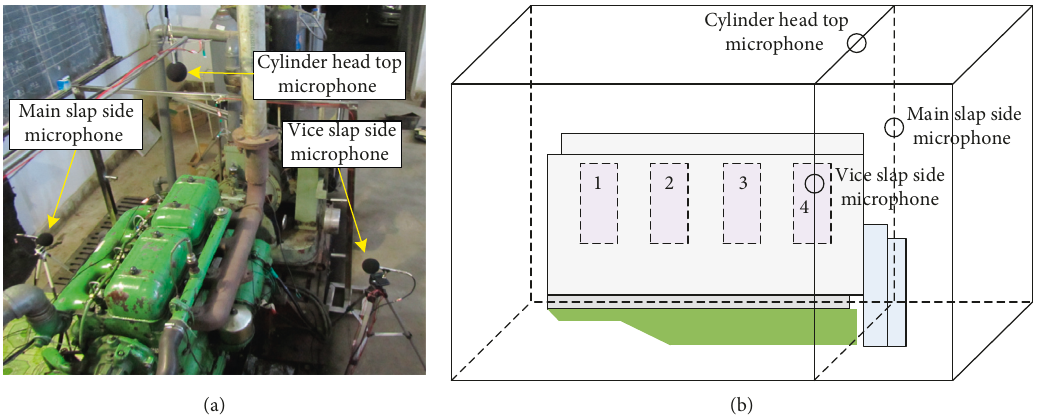
Figure 6: Microphone layout. (a) Test site diagram and (b) schematic